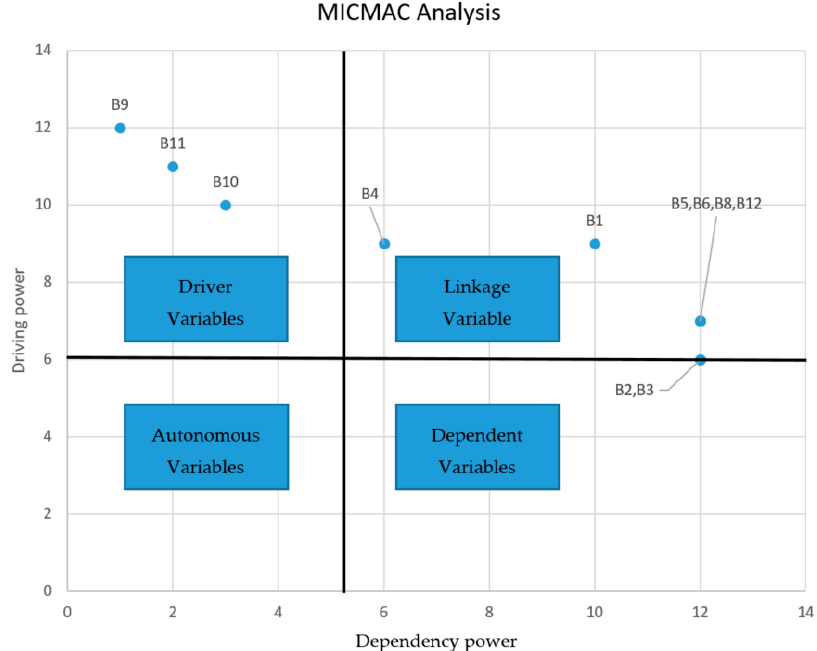
Figure 8. Results of Cross-Impact Matrix Multiplication Applied to Classification (MICMAC) analysis of barriers.